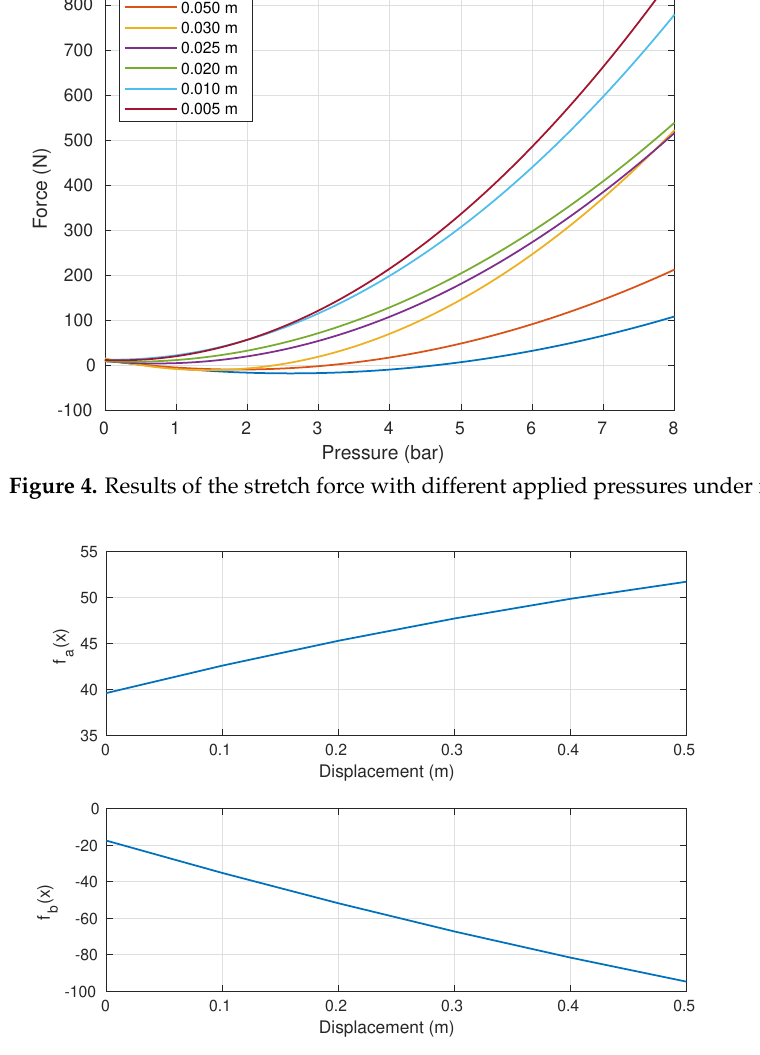
Figure 5. Results of F active = f a ( x ) P + f b ( x ) versus length change. Generally, the identified parameters are listed in Table 1. The identification accuracies of each curve are shown in Table